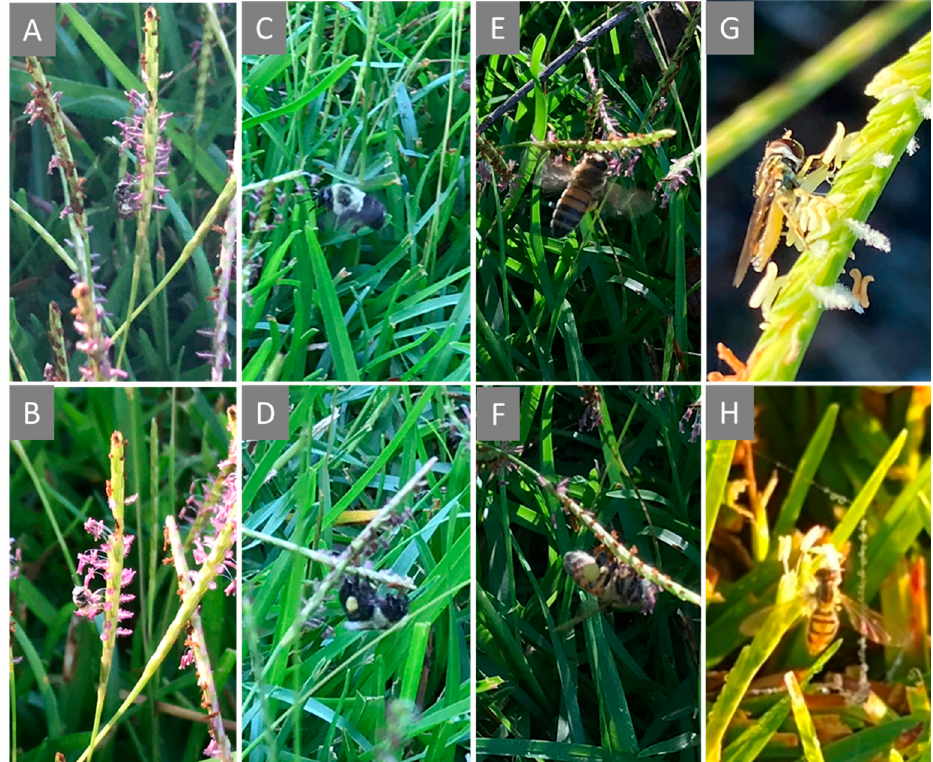
Figure 2. Foraging activity of (( A ) and ( B )) a halictid ( Lasioglossum spp.), (( C ) and ( D )) a bumble bee ( Bombus spp.), (( E ) and ( F )) a honey bee ( Apis spp.), and (( G ) and ( H )) a syrphid fly on the spike-like inflorescences of centipedegrass in a residential lawn during September 2020. Photo credit: ( A – F ), Shimat Joseph; ( G ), Karen Harris-Shultz; and ( H ), Michael Purvis, USDA ARS, Tifton, GA, USA.